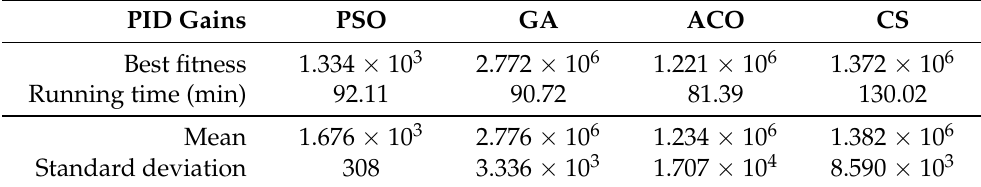
Table 8. The fitness, the running times of the four PID controllers’ gains optimisation algorithms and the mean and standard deviation of the ten experiments conducted for forward